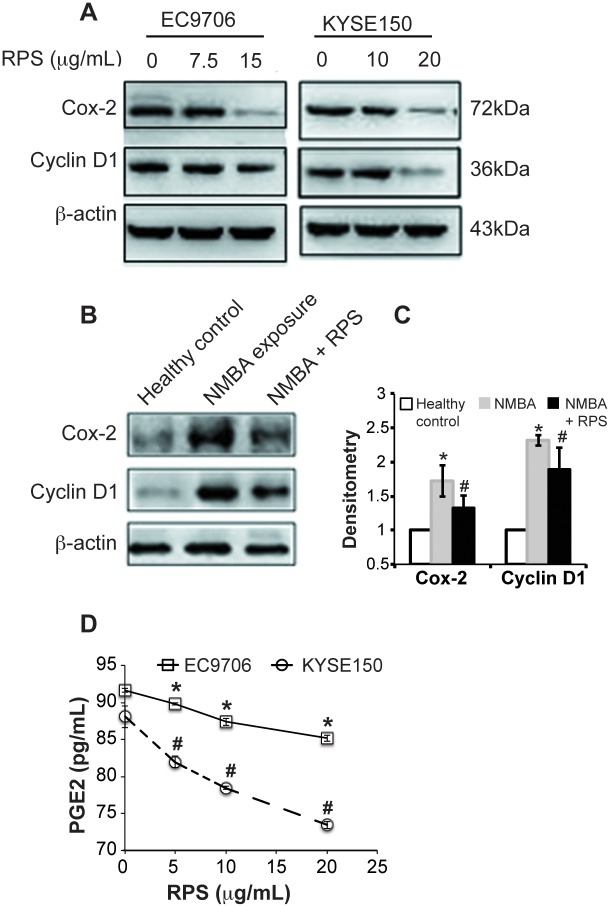
RPS reduced the expression of COX-2 and Cyclin D1 and the release of PGE2.
A. RPS reduced the expression of COX-2 and cyclin D1 in esophageal cancer cells. EC9706 cells were treated with RPS at 0, 7.5, or 15 μg/mL for 24h. KYSE150 cells were treated with RPS at 0, 10, or 20μg/mL for 24h. The cells were then harvest and lysed. Protein extract (30 μg) were separated by SDS-PAGE and transferred to the nitrocellulose membranes. The membranes were probed with rabbit anti rat β-actin, COX-2, or cyclin D1. Representative images were presented. B. RPS reduced the expression of COX-2 and cyclin D1 in esophageal tissues. Esophageal tissues from rats were homogenized and protein extract (30 μg) were separated by SDS-PAGE and transferred to the nitrocellulose membranes. The membrane was probed with rabbit anti rat β-actin, COX-2, or cyclin D1. Representative images are presented. C. Densitometry analysis of the western blot in B. Average values of 5 rats are presented, n = 5. * represents significant difference between NMBA group vs healthy control group, P < 0.01. # represents significant difference between NMBA +RPS group vs NMBA group, P < 0.01. D. RPS decreased the release of PGE2 from esophageal cancer cells. Cells were cultured in serum-free media containing 0, 5, 10, or 20 μg/mL RPS for 24 h. The culture supernatants were collected and centrifuged at 12, 000 rpm for 10 min to remove cell debris. The level of PGE2 in the supernatants was determined by ELISA kit according to the protocol provided by the manufacturer, n = 3. * and # represents significant difference at 5, 10, and 20 μg/mL of RPS compared to 0 μg/mL of RPS in EC9706 cell and KYSE150 cells, respectively, P < 0.01.